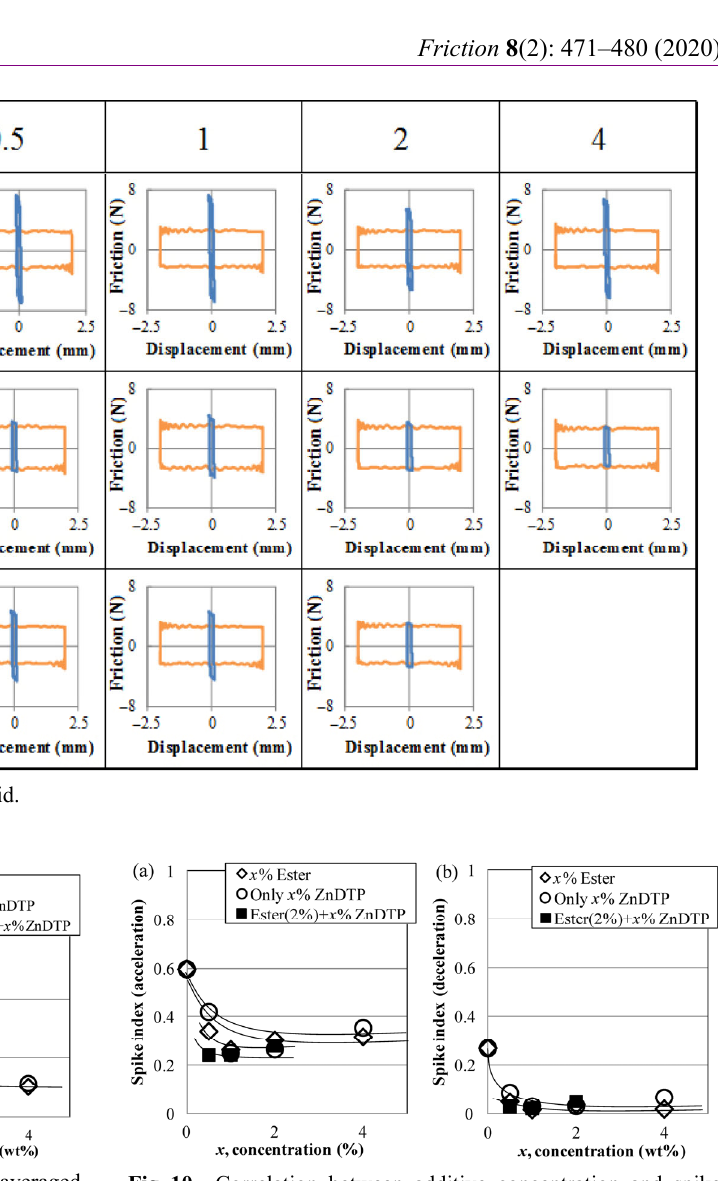
| https://mc03.manuscriptcentral.com/friction